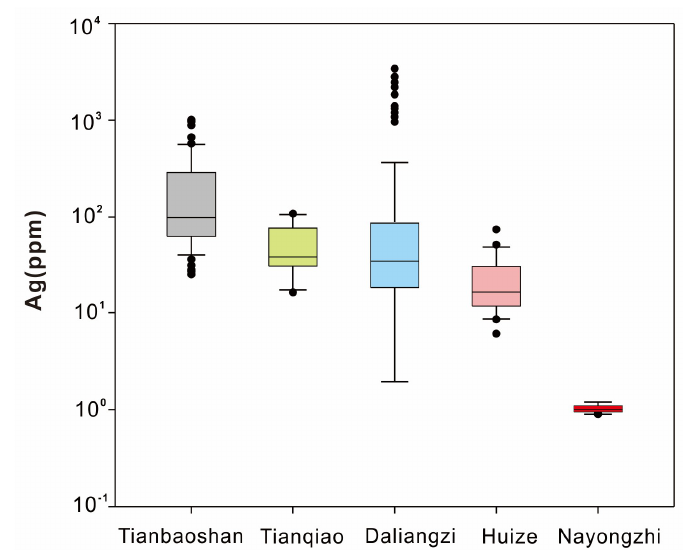
Figure 13. Ag content of sphalerite from Tianbaoshan, Daliangzi, Huize, Tianqiao and Nayongzhi deposit in S-Y-G Zn-Pb metallogenic province. Note: plots are based on data from Ye et al. [5,15], Li et al. [70] and Yuan et al. [71]. Minimum, maximum, median, lower quartile and upper quartile are indicated by the lowest point, the uppermost point, the line across the rectangular box, the upper boundary of the rectangular box, the lower boundary of the rectangular box of each column, respectively.